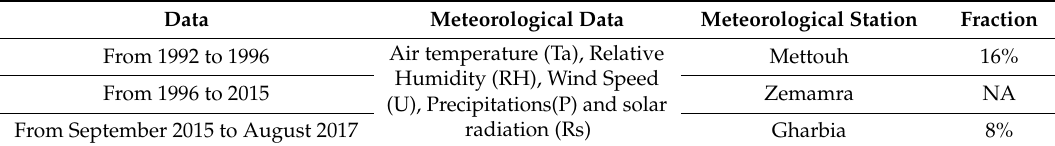
Table 1. Data availability at the meteorological stations in the study area; fraction is the percentage of missing observations at Zemamra replaced by observations at Metthouh and Gharbia, respectively.